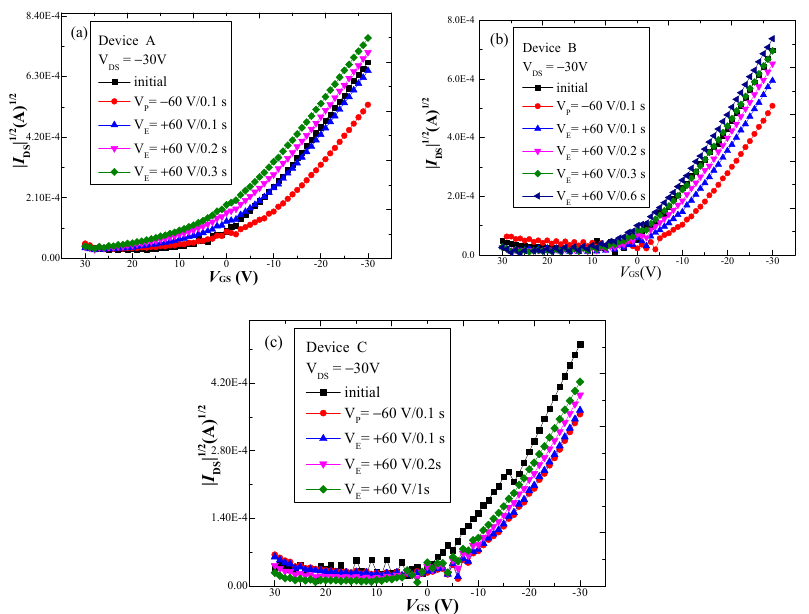
Figure 5. ( a )–( c ) Memory characteristics of devices A, B and C.